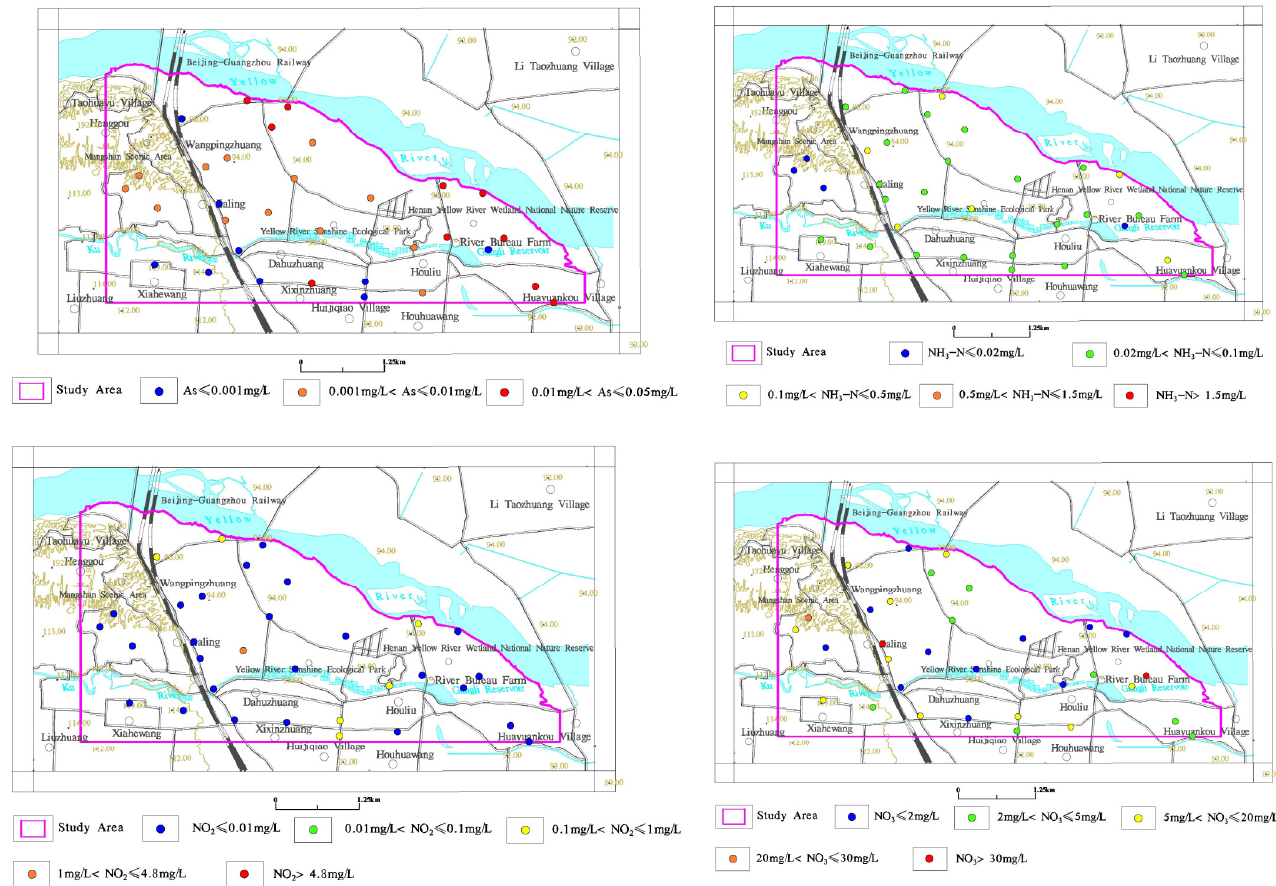
Figure 11. Typical indicator concentration evaluation map in groundwater in the study area (As, NH 4 , NO 2 − , and NO 3 − , respectively).